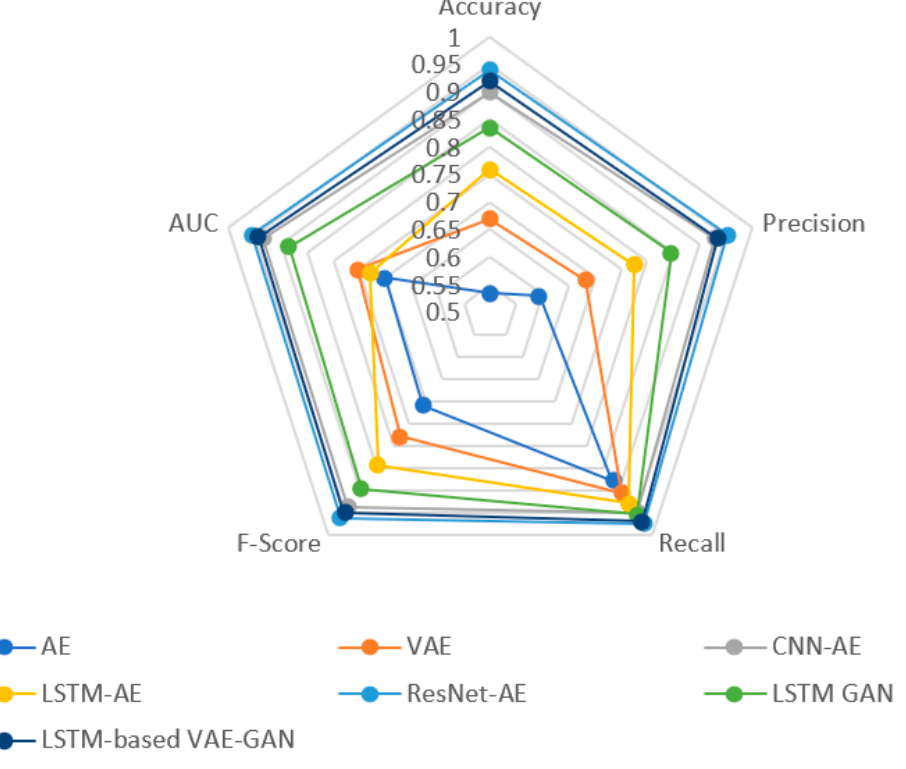
Figure 10. Result evaluation of common anomaly detection models.